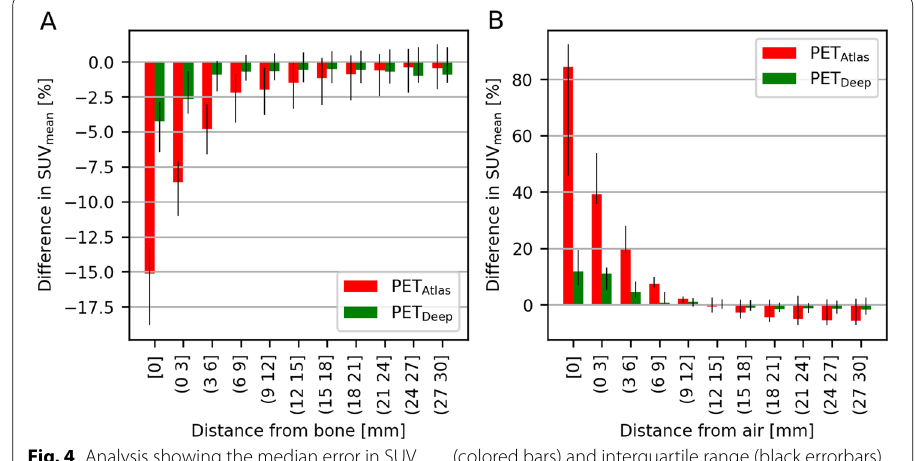
Fig. 4 Analysis showing the median error in SUV mean (colored bars) and interquartile range (black errorbars) as a function of distance to either ( A ) bone or ( B ) air